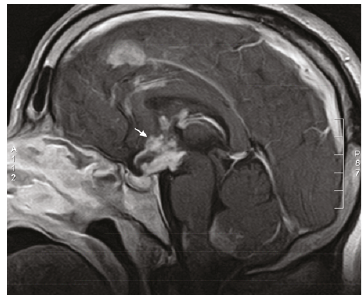
Figure 1: Brain magnetic resonance image showing neurosarcoidosis involving the hypothalamus and pituitary.